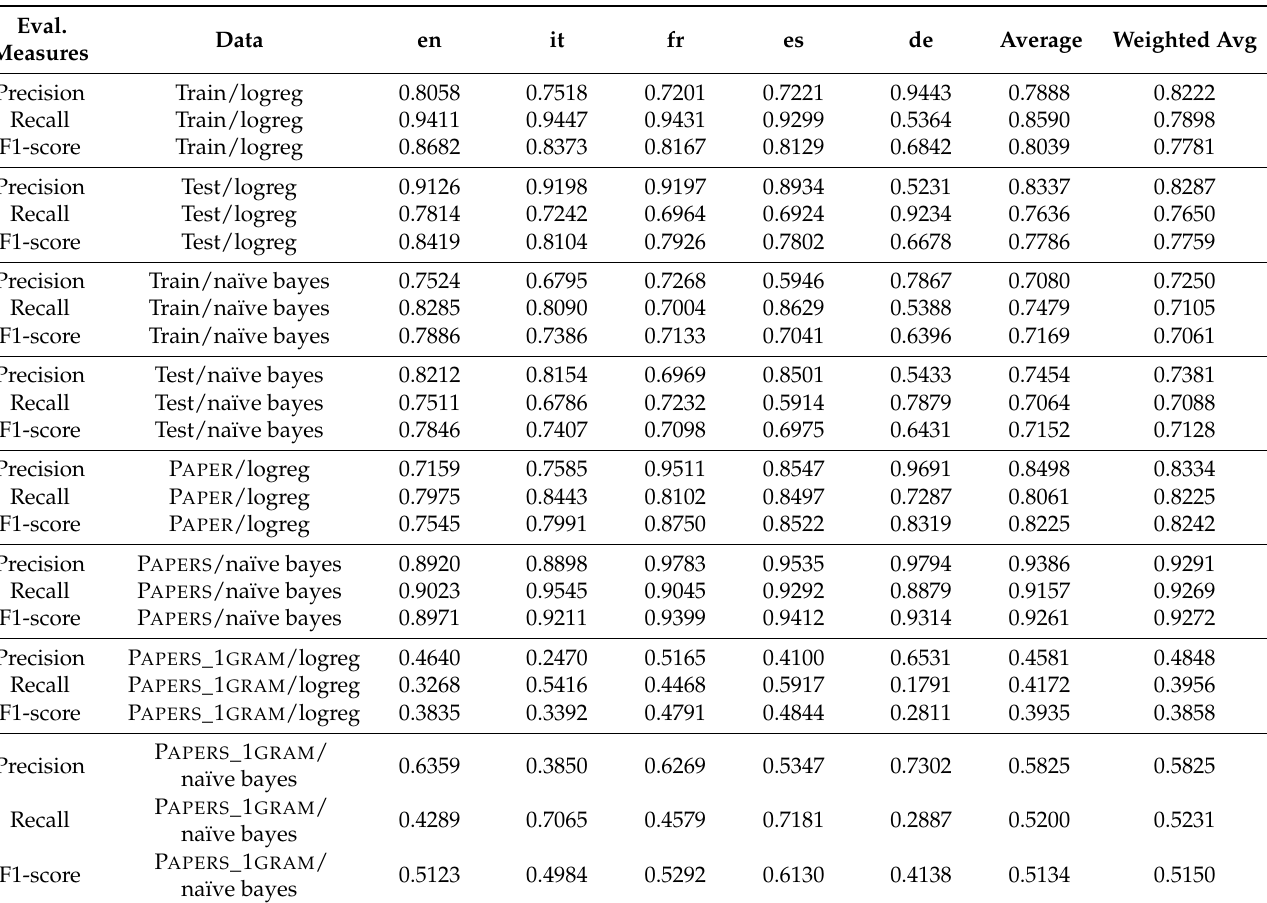
Table 4. Results for the classifiers trained on WIKITXT dataset, using character trigrams, and 1200 max